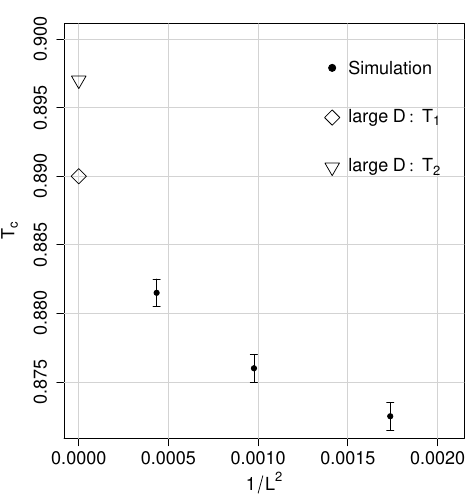
Figure 9. Values for T c extracted from the two-peak histograms extrapolated to the large- N limit for various values of L . On the left, we show the continuum results from the next-to-leading large- D expansion at D = 26.